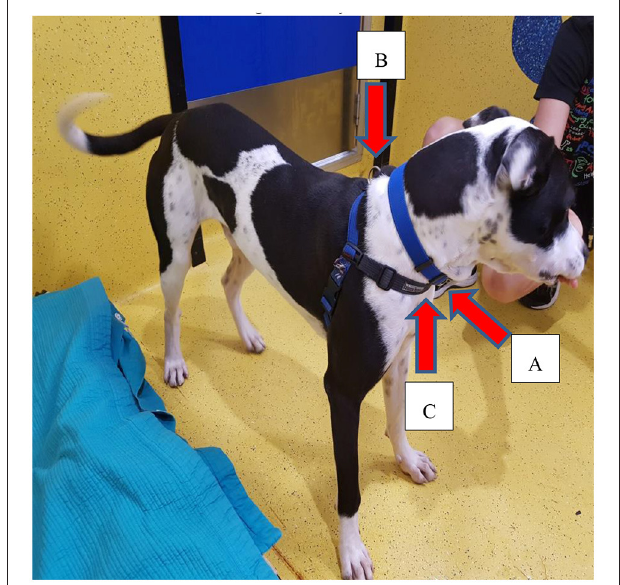
FIGURE 1 | Dogs at RSPCA QLD wore both the collar and harness both during their daily walking routine and throughout the entire duration of the study. In this study, the leash tension metre (RobacScience, New South Wales, Australia) was connected to the collar (A) and harness (B) to test the pulling of dogs with both restraint types. The harness has one more front-attaching ring at the chest level (C) which is not shown in this